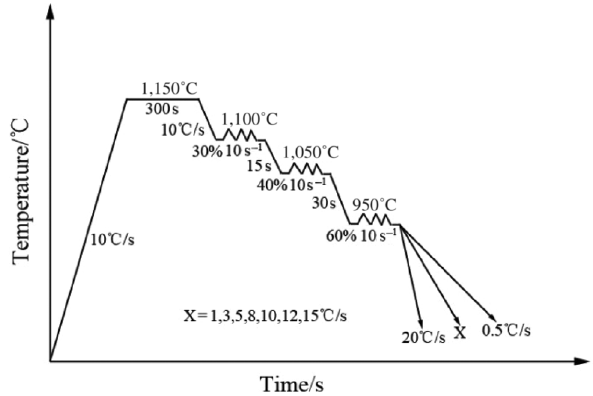
Figure 1: Schematic illustration of thermo-mechanical simulation